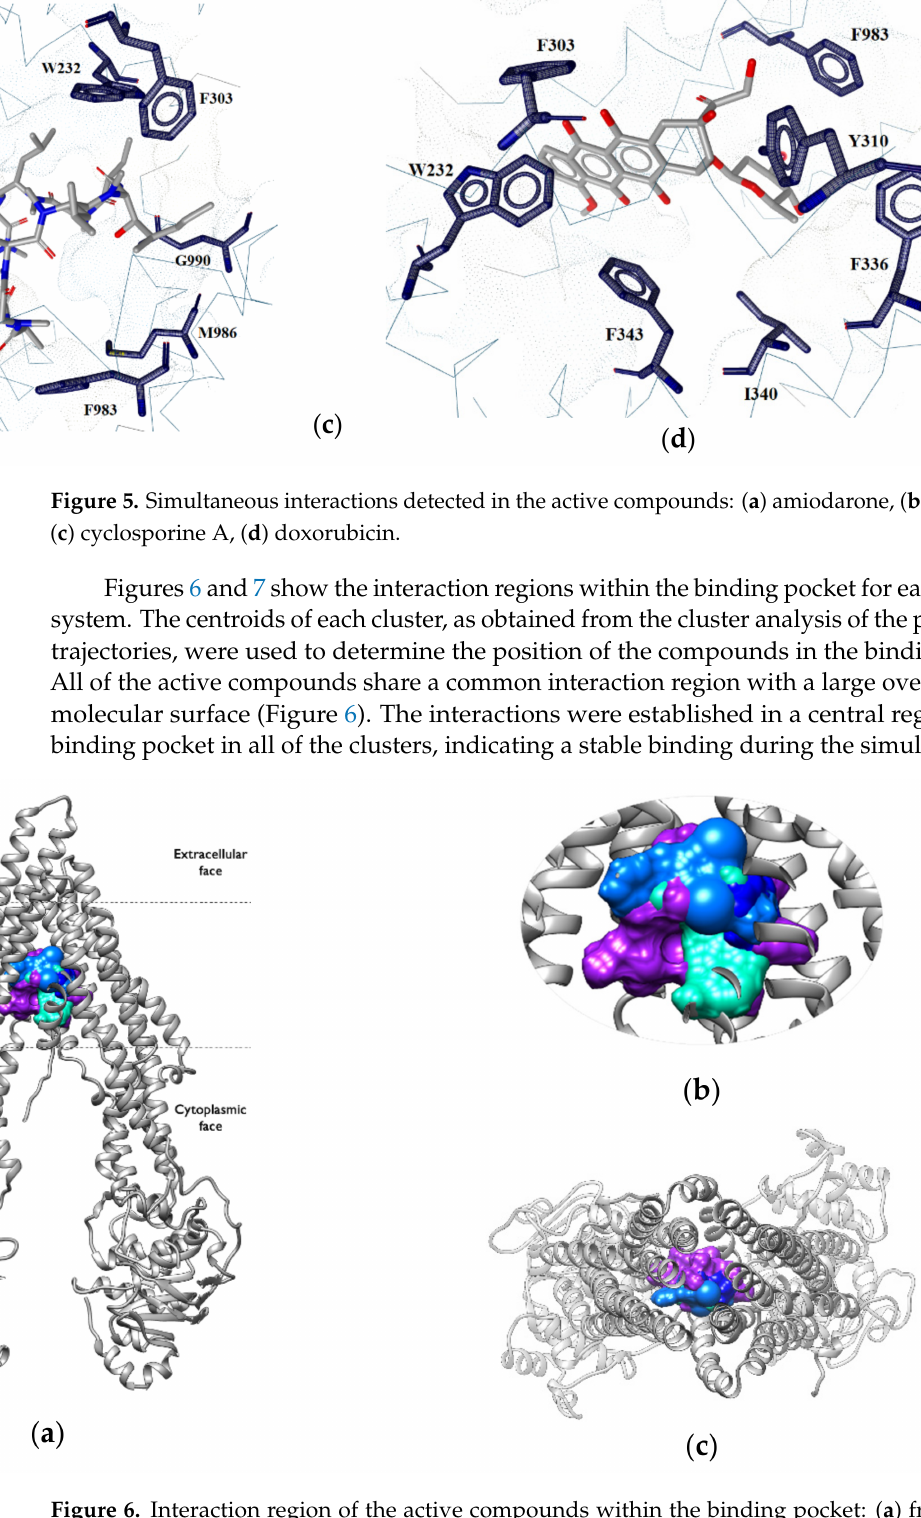
Figure 6. Interaction region of the active compounds within the binding pocket: ( a ) frontal view, ( b ) zoomed view, ( c ) view from the extracellular side of the protein looking into the inner chamber. The ligands are shown in surface representation; AMI is shown in lighter blue, CAR is shown in blue, CSA is shown in purple, and DOX is shown in